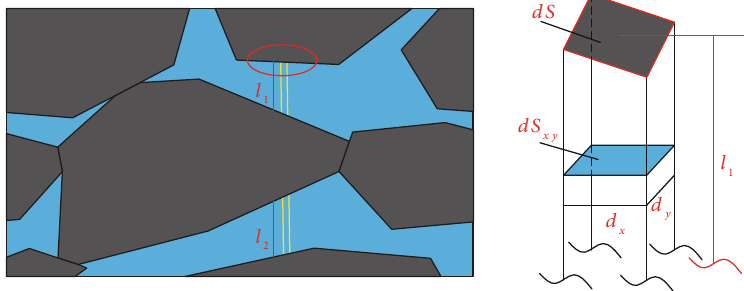
Figure 9: Diagram of a speci fi c surface area of water in the